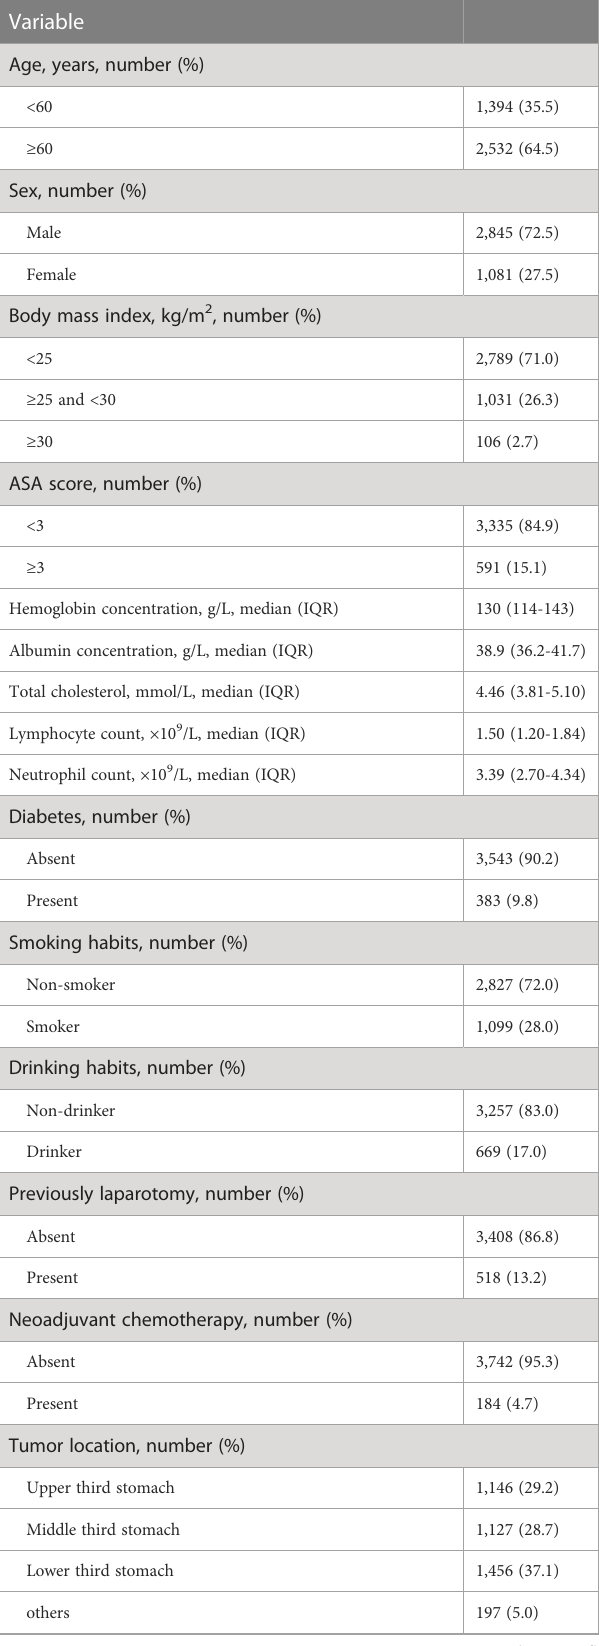
TABLE 1 Clinicopathological and operative characteristics of the 3,926 patients who underwent